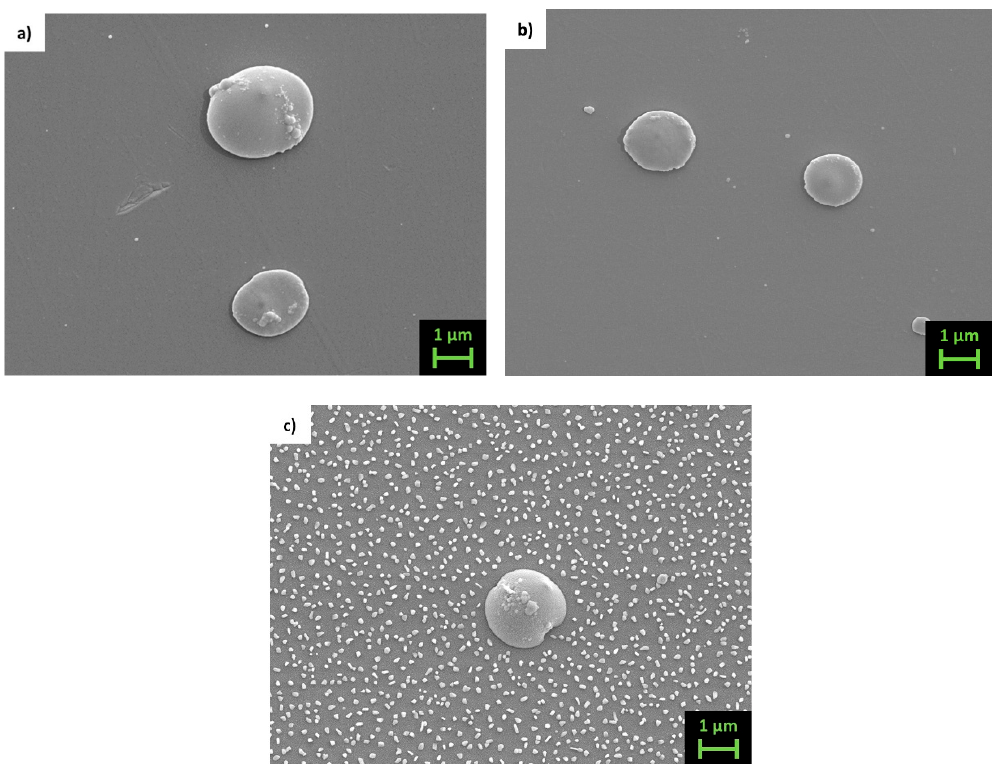
Figure 5. Top view LED-SEM images of samples ( a ) Fe63_RT, ( b ) Fe63_ann and ( c ) Fe63_423.